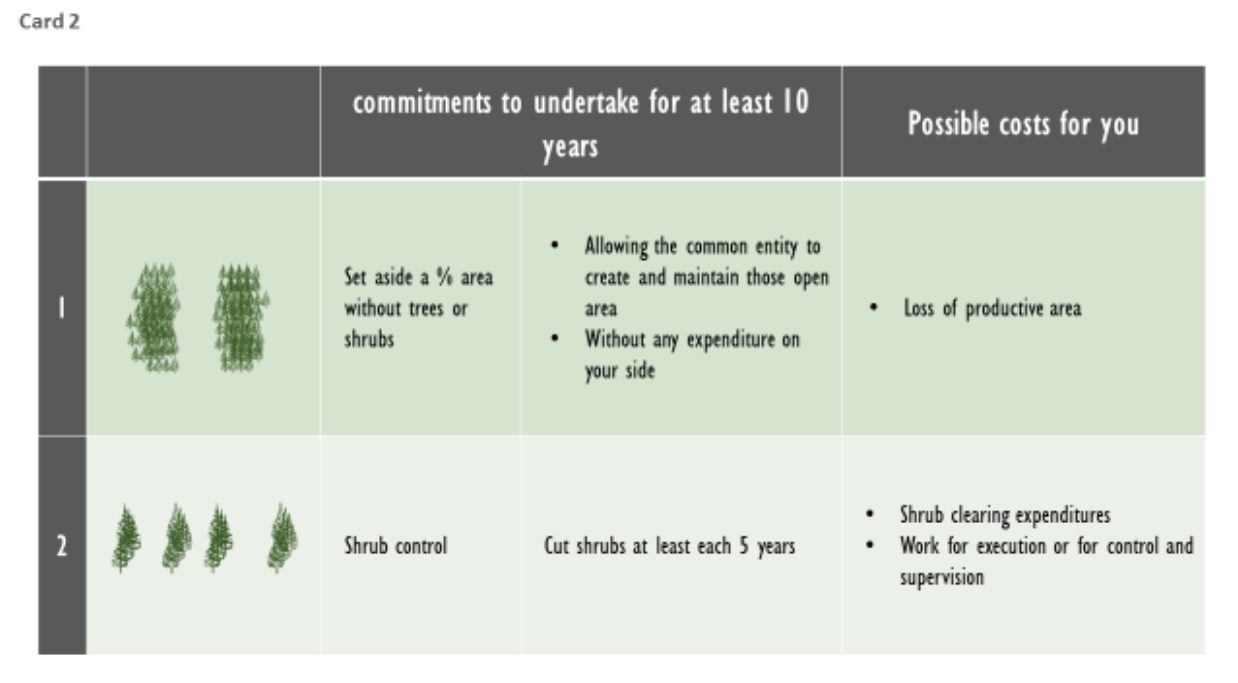
Figure A2. Card 2—visual presentation of the prevention measures (i.e., the choice experiment’s attributes shrub and fuel break) under the contract explained to the respondents. References 1.